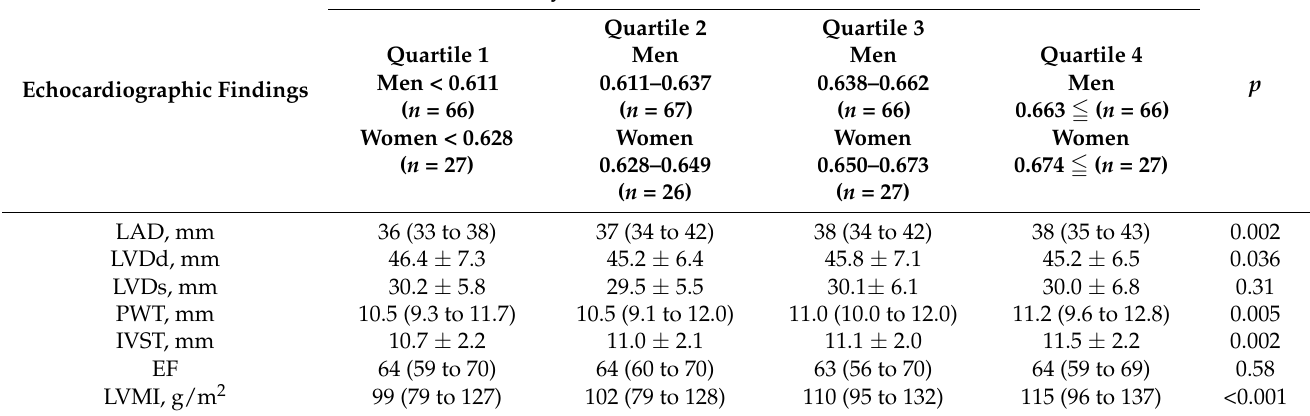
Table 2. Echocardiographic findings according to the post-dialysis extracellular to intracellular water ratio